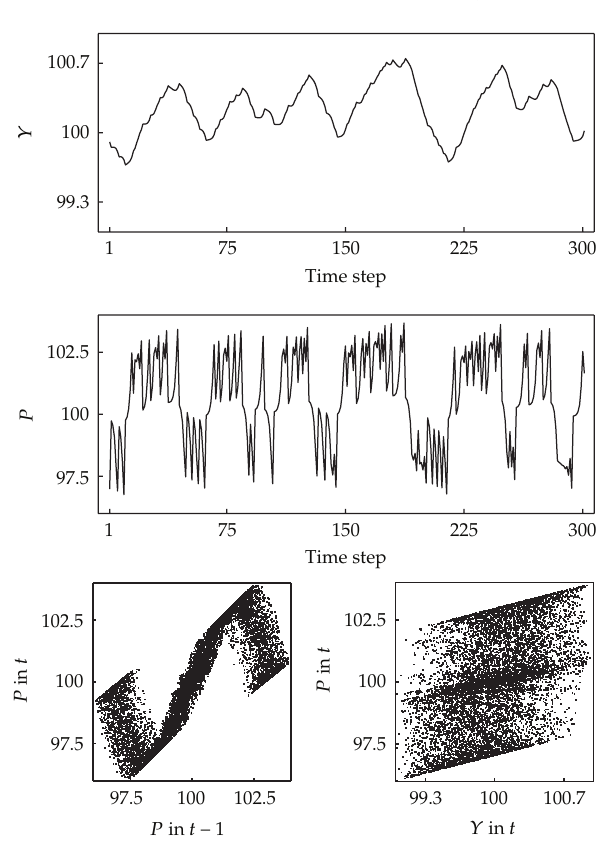
Figure 2: The dynamics of interacting goods and stock markets. Parameter setting as in Section